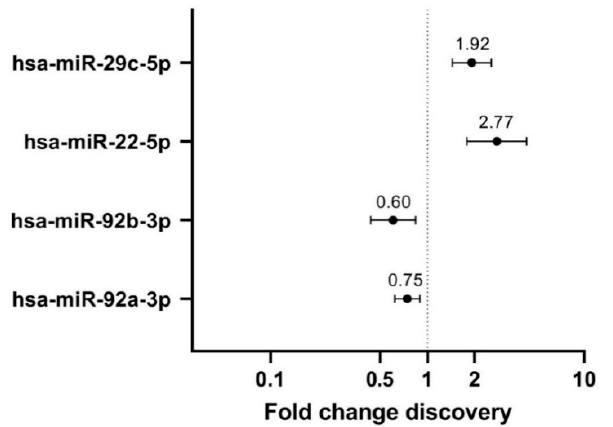
Figure 1. Linear regression-based fold changes in extremely high compared to very low mammo- graphic density derived nipple aspirate fluid, of the four differentially expressed miRNAs in the discovery cohort. miRNAs with p -values < 0.2 were considered of interest for subsequent validation. miR-92b-3p ( p = 0.139) and miR-92a-3p ( p = 0.125) were negative predictors for extremely high MD (downregulated versus very low MD), whereas miR-22-5p ( p = 0.027) and miR-29c-5p ( p = 0.031) were positive predictors for extremely high MD (upregulated versus very low MD).